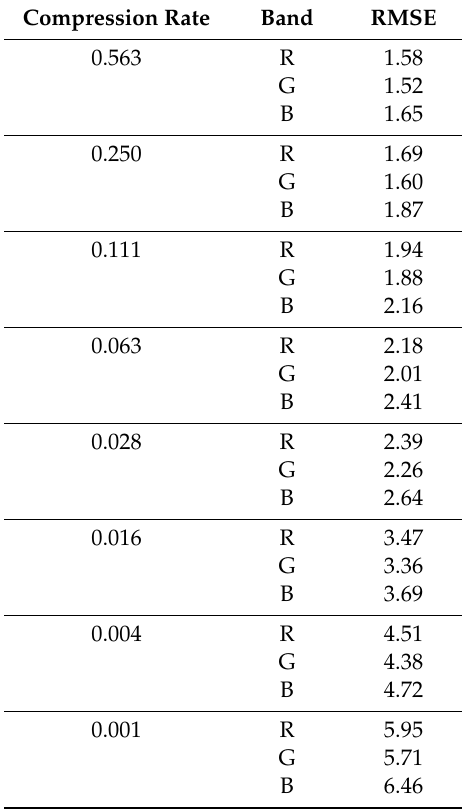
Table 1. Root mean square error (RMSE) measures for the image Mona Lisa.